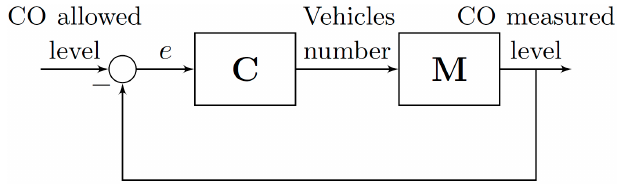
Figure 1. The schematic concept of a vehicle emission control system.